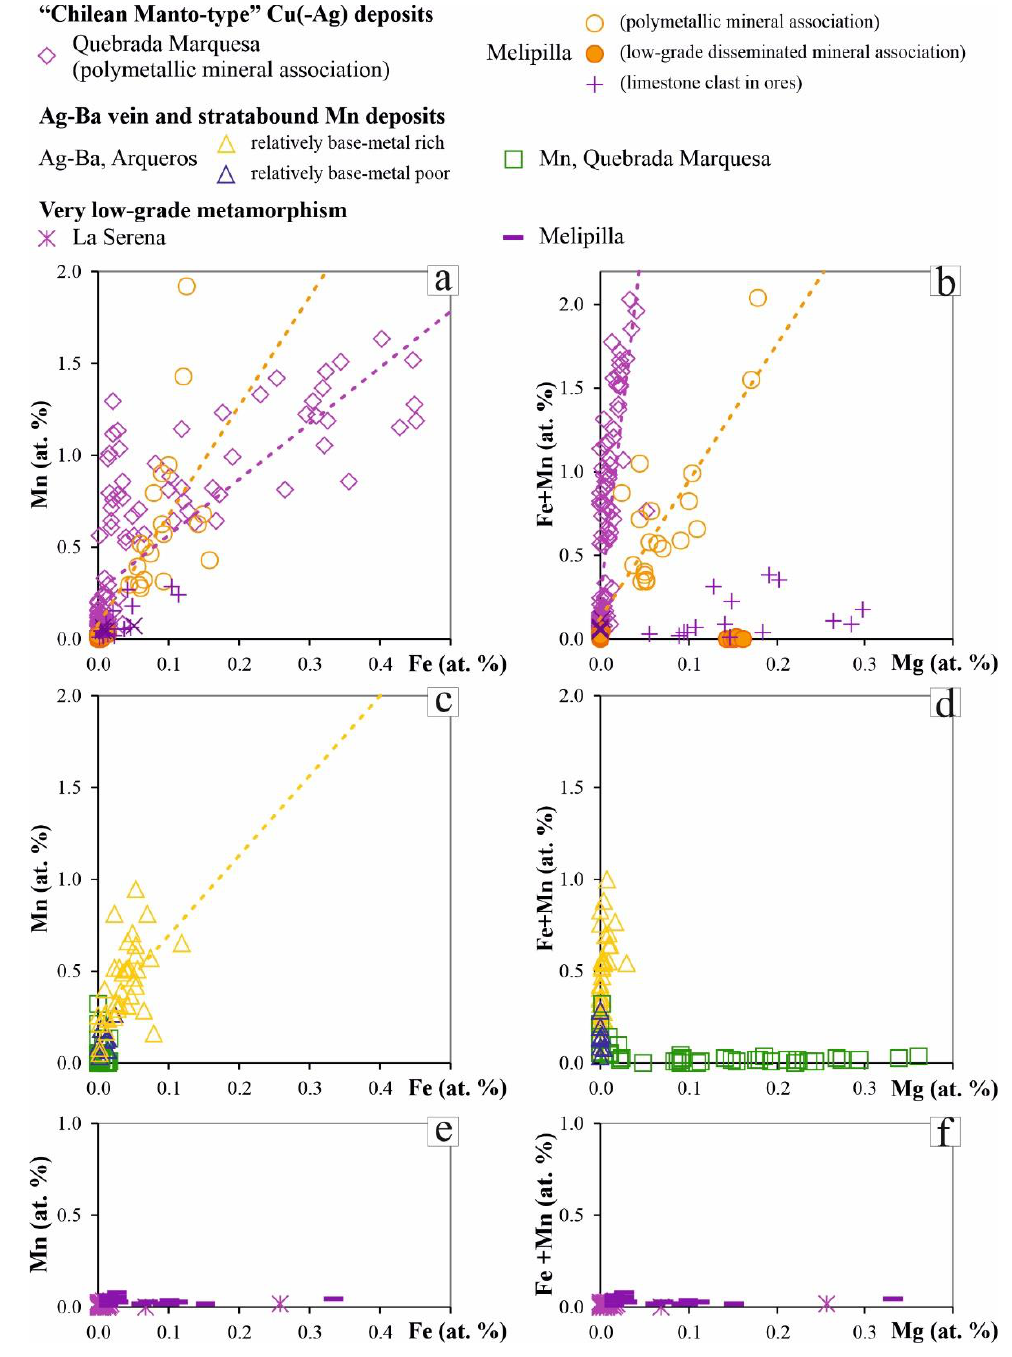
Figure 8. Fe vs. Mn and Mg vs. Fe+Mn in atomic % showing the composition of calcite from different mineralizations/very low-grade metamorphism in central Chile: ( a , b ) “Chilean Manto-type” Cu(-Ag) deposits (Quebrada Marquesa -La Serena- and Melipilla, central Chile): Quebrada Marquesa polymetallic mineral association; Melipilla polymetallic mineral association; late calcites from Melipilla low-grade disseminated mineral association; calcite from limestone host rock in Melipilla polymetallic association. The dotted colored lines mark in ( a ) the correlation line between Fe and Mn (r 2 = 0.62 for Quebrada Marquesa and r 2 = 0.22 for Melipilla polymetallic association) and Mg and Fe+Mn (r 2 = 0.58 for Quebrada Marquesa and r 2 = 0.62 for Melipilla polymetallic association) in the propylitic hydrothermal alteration calcites. ( c , d ) Stratabound Mn deposits (La Serena, central Chile) and Ag-Ba veins (relatively base-metal rich and relatively base-metal poor). The dotted colred line marks in ( a ) the correlation line between Fe and Mn (r 2 = 0.27) in calcite from Ag-Ba, relatively base-metal rich, veins. ( e , f ) Very low-grade metamorphism in volcanic rocks from La Serena and Melipilla areas (central Chile).